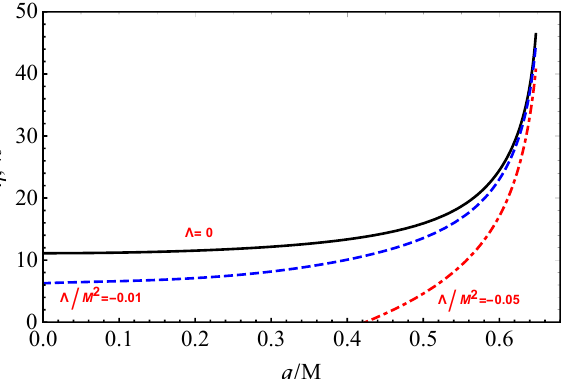
Figure 16. The radiative efficiency of the accretion disk around the regular Bardeen BH in AdS spacetime as a function of the BH magnetic charge for the particle with β = 10.2.